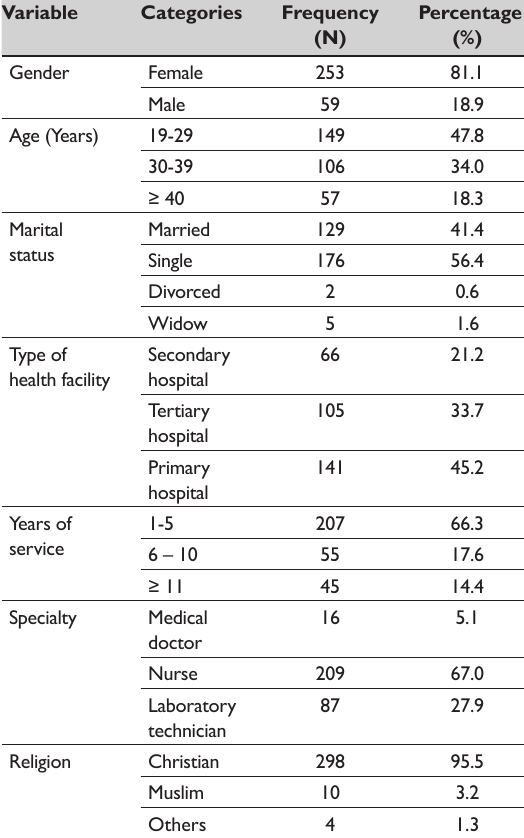
Table 1: Socio-demographic characteristics